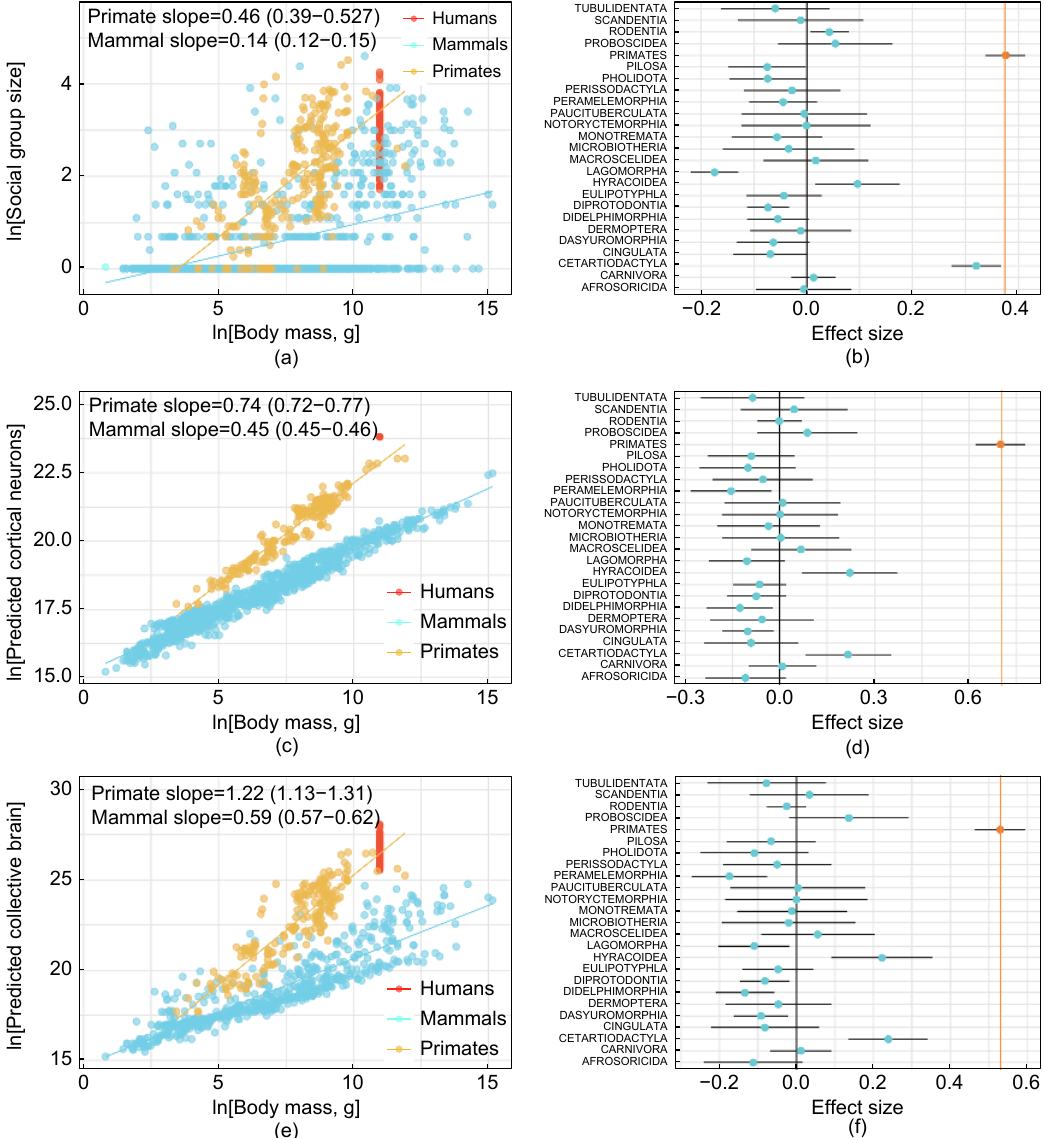
Fig. 3 Allometric scaling of collective features of groups by body size across hunter-gatherers (red), primates (orange), and mammals (blue). In the panels on the left, the fitted functions are OLS regressions and the slope parameters are in the upper left. The panels on the right are the effect sizes for each mammal order from a mixed linear model of the data on the left. The vertical line is a zero effect and the orange vertical line is the primate effect size. In each case, the positive random effect size for mammals is much greater than any other mammal order. (a) The allometry of group size and body size is 3-fold steeper in primates than other mammals, and hunter-gatherers have a broad range of band sizes. (b) The random effect for primates shows the primate group size allometry is much steeper than other mammal orders with the exception of cetartiodactyls (even-toed ungulates). (c) The allometry of the estimated number of cortical neurons in the brain is much steeper in primates than other mammals, and humans have more cortical neurons for their body size than other primates. (d) The random effect for primates indicates the response of a change in the number cortical neurons to a change in body size is much greater in primates than other mammals. (e) The allometry of the estimated collective brain (group size cortical neurons) in mammals, primates, and humans. (f) The effect size for primates is much greater than other mammal orders, showing that the collective brain of primate groups increases significantly faster than any other mammal. Hunter-gatherer collective brain sizes are much as predicted for a primate of our body size as smaller than predicted group sizes are compensated by larger than predicted cortical neurons. The primate allometry is twice as steep as other mammals. Nevertheless, human hunter-gatherers have the largest collective brains of all species in the